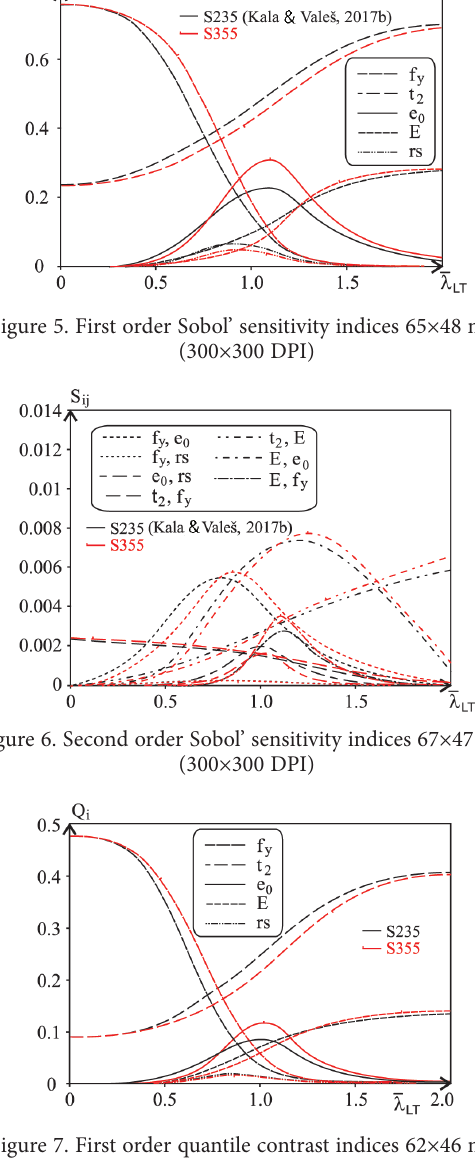
Figure 7. First order quantile contrast indices 62×46 mm (300×300